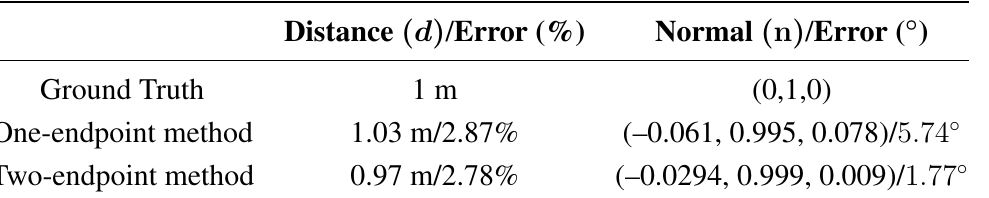
Table 1. Scene depth information using simulated data and multiple azimuth observations of the conic pattern. A noise of 5 ◦ is added to the three angles representing the laser orientation and its projection in the image.